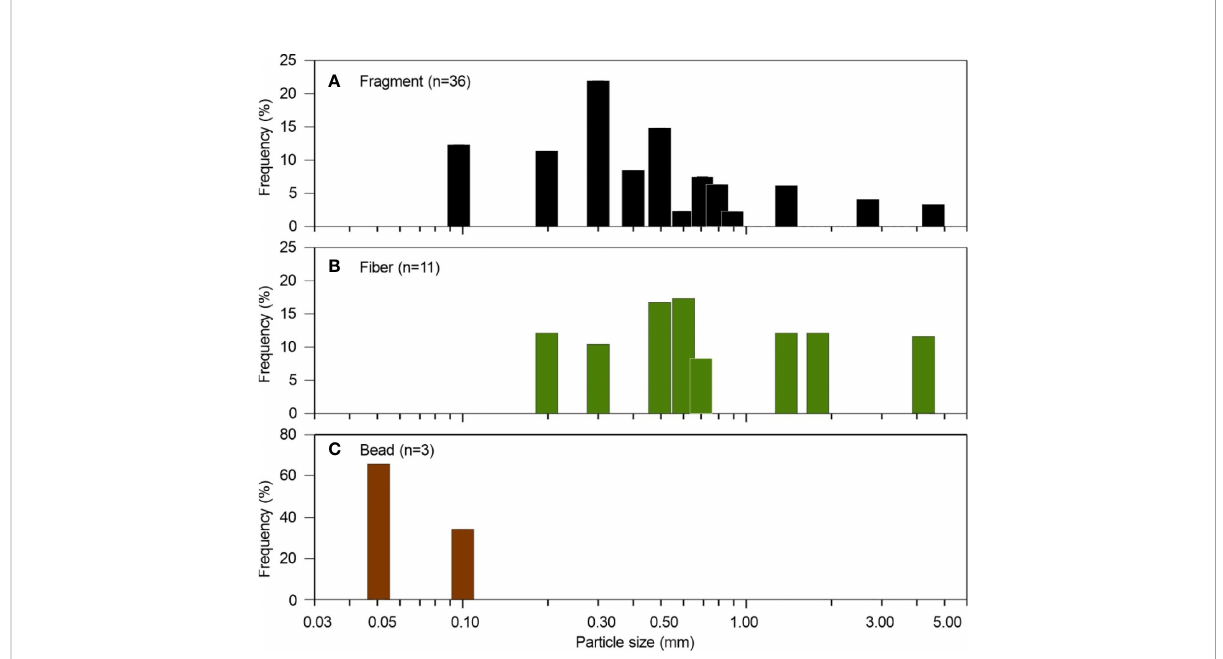
FIGURE 7 Frequency histograms of the microplastic particle size of (A) fragment, (B) fi ber, and (C) bead in surface sediments of the northern South China Sea. n = number of microplastic